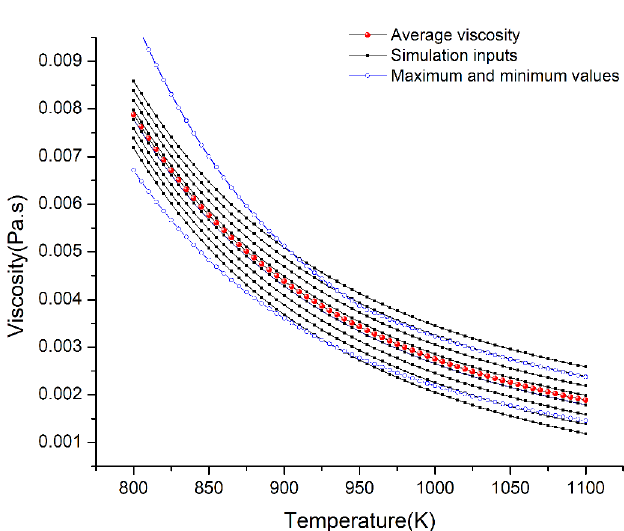
Fig. 8. Viscosity inputs for the sensitivity analysis CFD